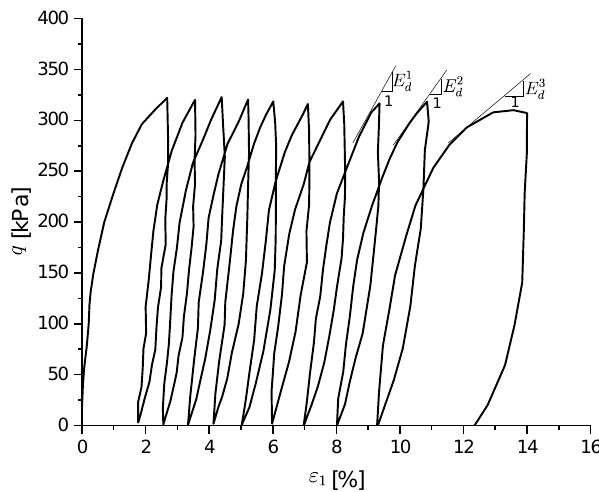
Figure 5. Cyclic failure under a high CSR.